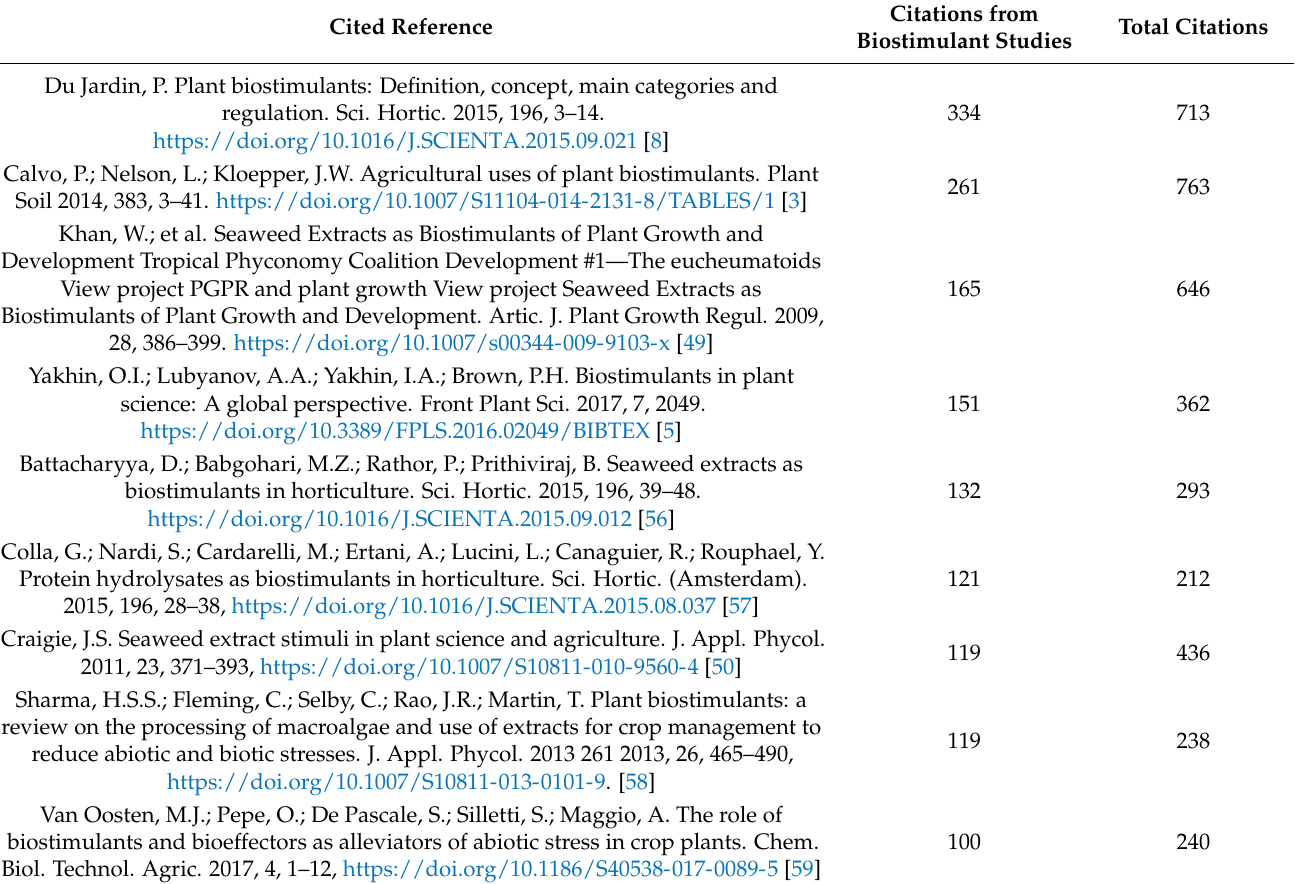
Table 5. Top 15 most cited publications in the biostimulants